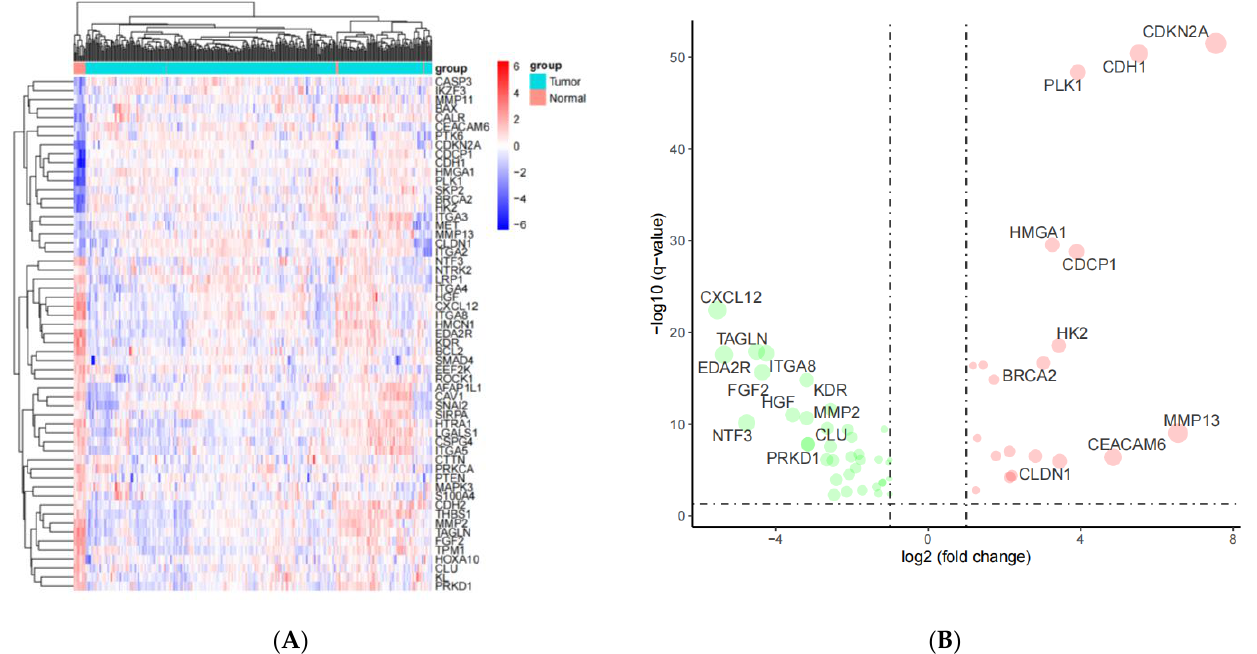
Figure 1. The identified differentially expressed anoikis-related genes (ANRGs). ( A ) Heatmap of the ANRGs in cervical squamous cell carcinoma and endocervical adenocarcinoma (CESC). ( B ) Volcano plot of differentially expressed ANRGs. p -values of <0.05 and |logFC| values of >1 were utilized as the filtering criteria.